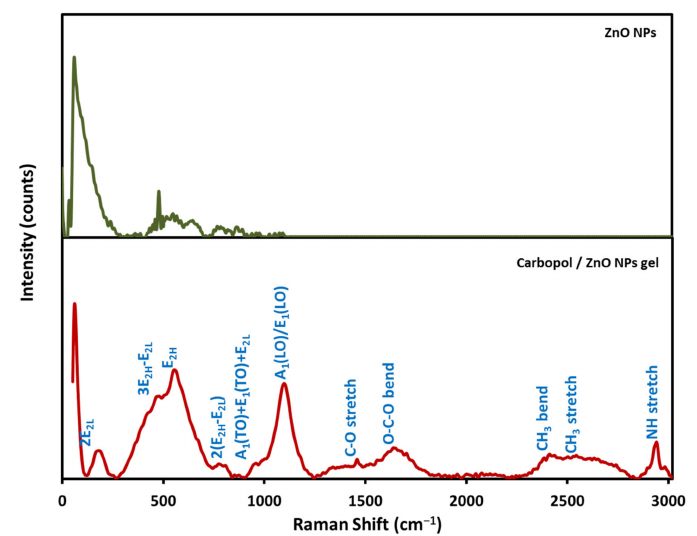
Figure 4. Raman shift spectrums of the synthesized ZnO NPs and Carbopol/ZnO hybrid nanoparti- cles